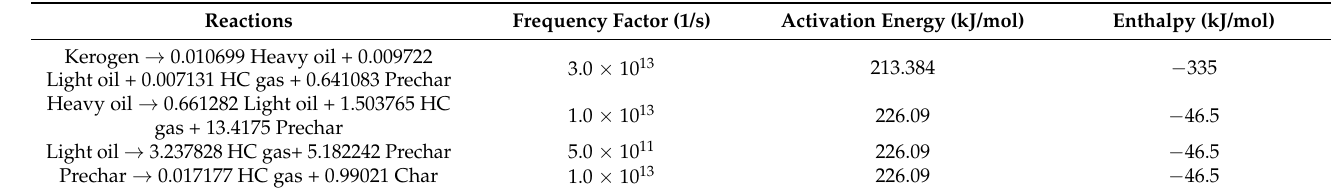
Table 1. Reaction model for multistage pyrolysis of kerogen